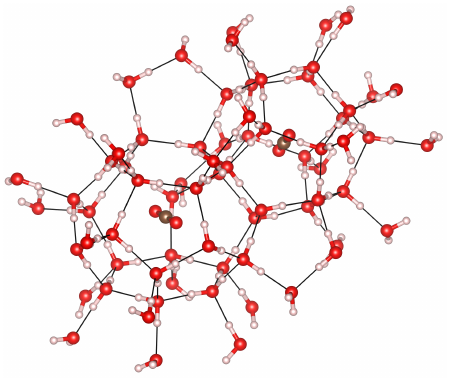
Figure 2. Geometry of the cluster model used in the vibrational calculations taken from the optimized crystalline